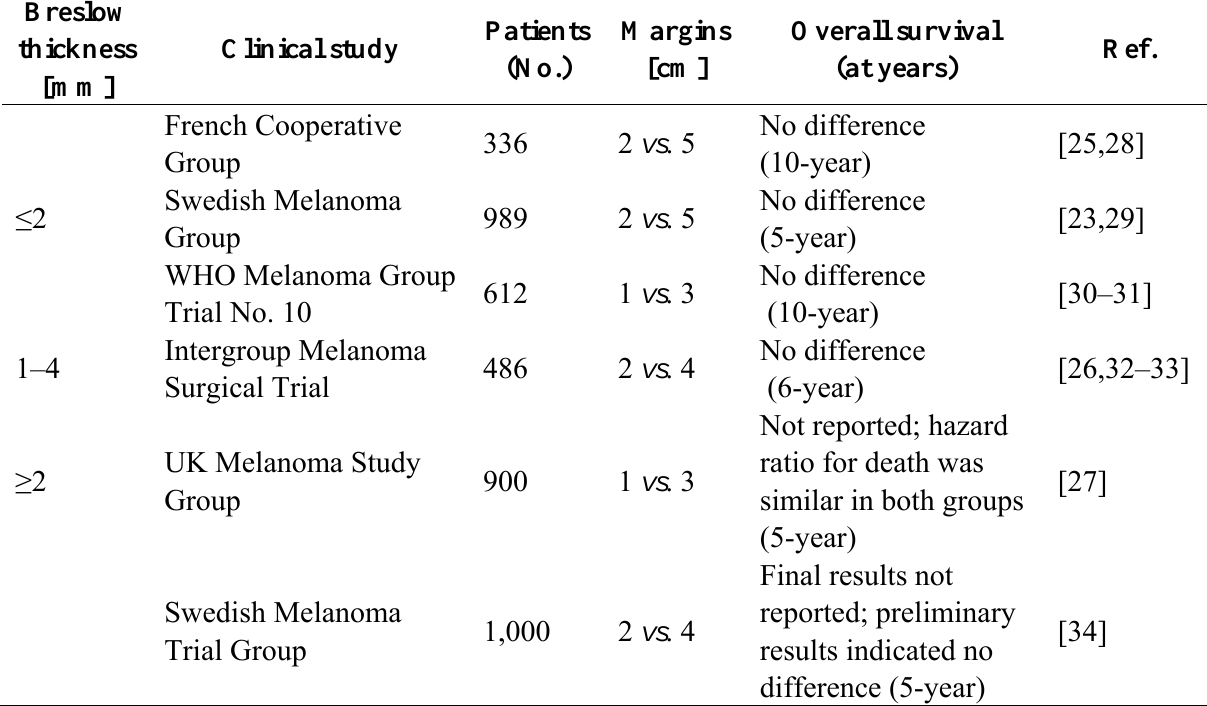
Table 1. Clinical trials evaluating the width of radical excision surgical margins for primary